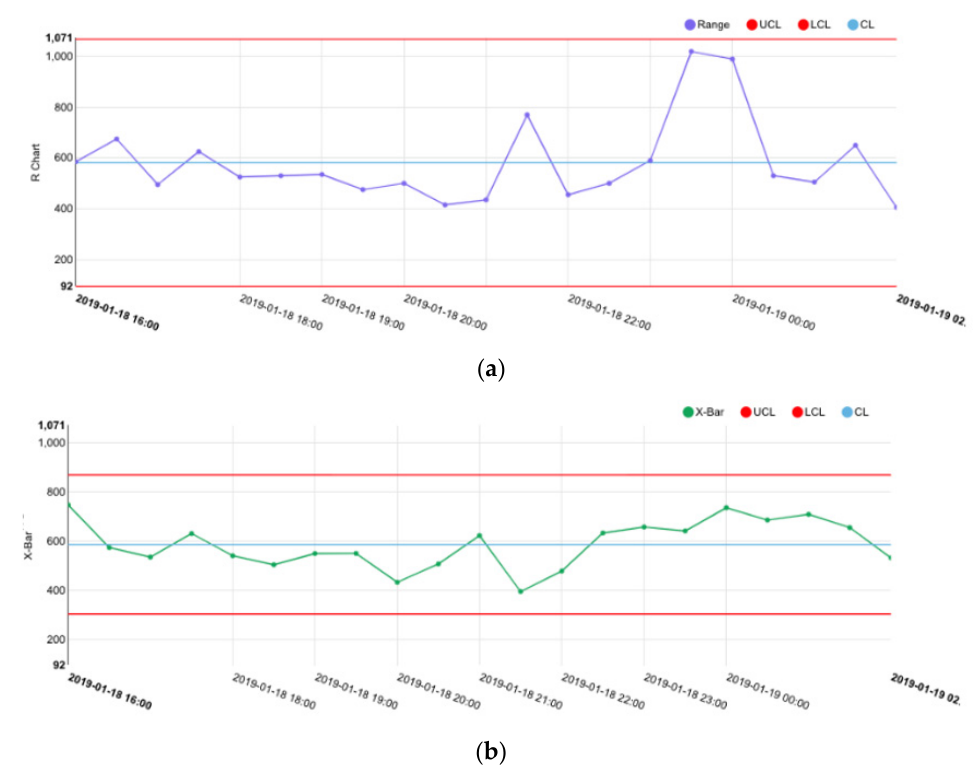
Figure 8. Result of various charts in real-world manufacturing processes; ( a ) result of X chart and ( b ) result of R chart.